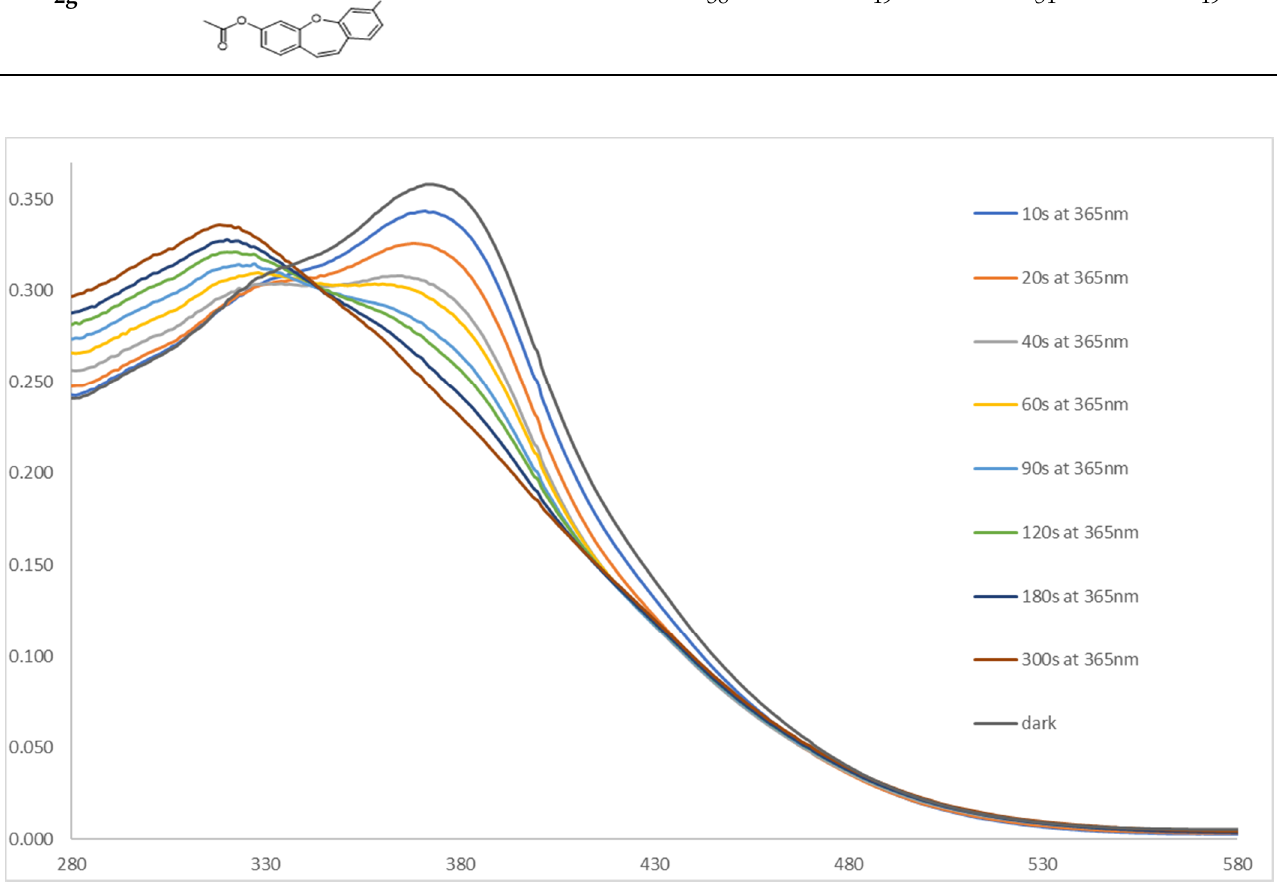
Figure 4. The hypsochromic shift in UV/VIS spectra of compound ( 2f ) upon irradiation with 365 nm. Table 5. Percentages of ( Z ) ( 2a , 2b , 2e , 2g ) isomers obtained from NMR spectra and at various PSSs (photostationary state) measured under constant illumination at the indicated wavelengths.